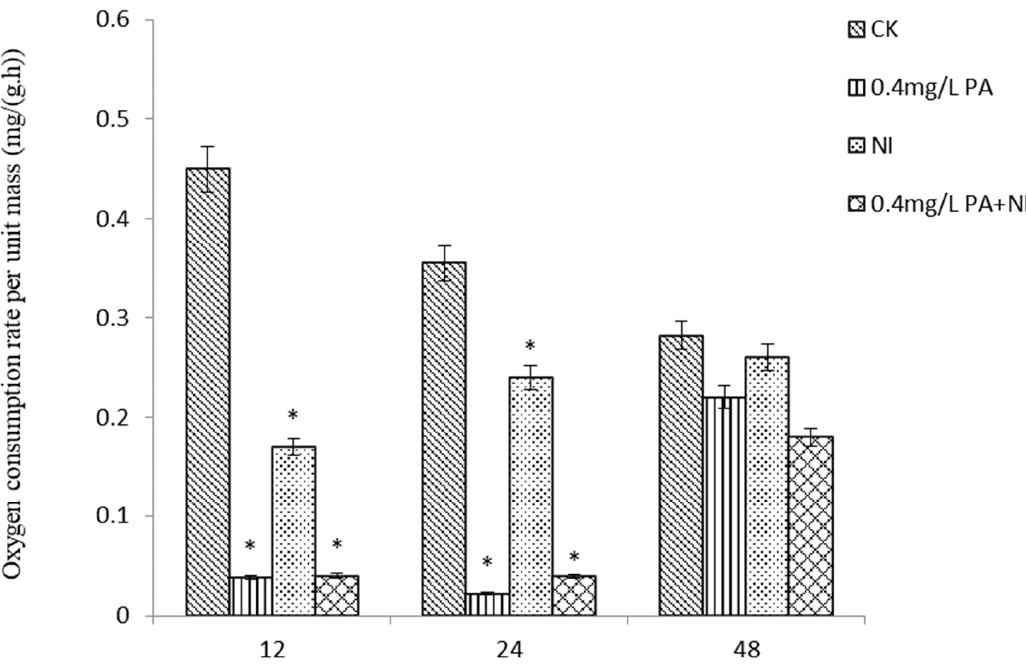
Figure 3. The effect of the drug on the oxygen consumption rate. *— p <